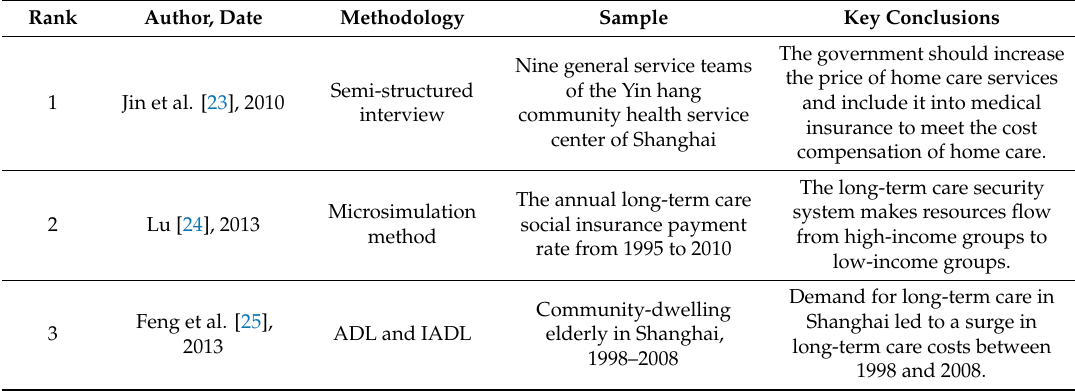
Table 2. Literature related to the measurement of Long-Term Care (LTC) costs in